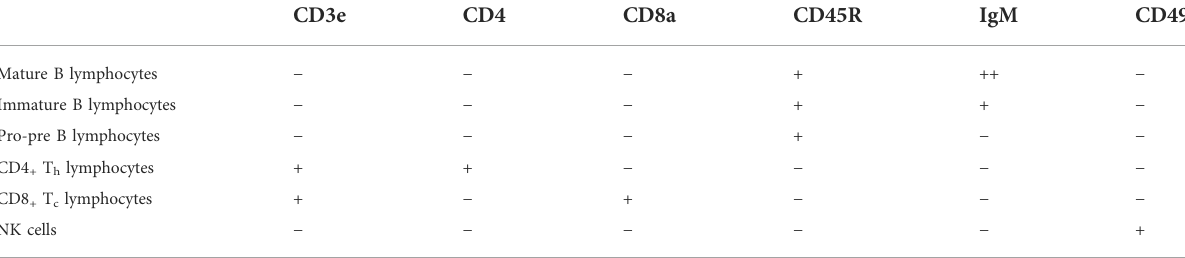
TABLE 2 Cell surface markers used to identify splenocyte